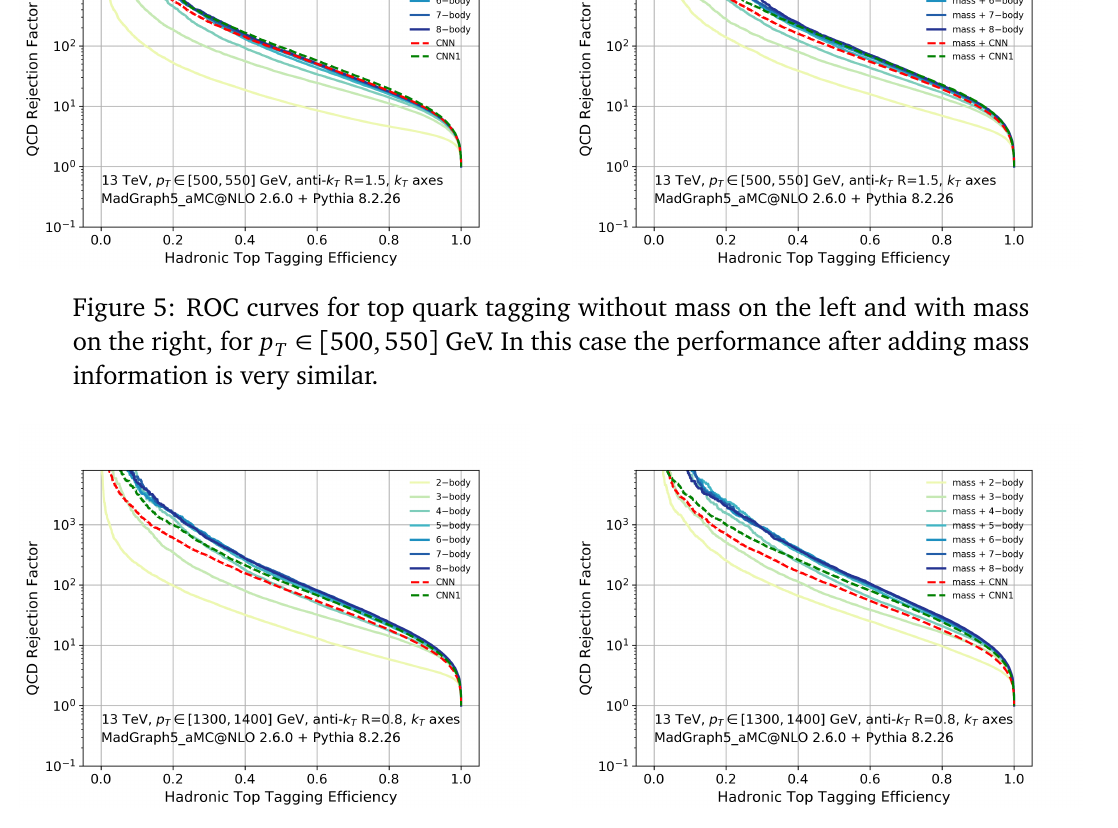
Figure 6: ROC curves for top quark tagging without mass on the left and with mass on ∈ [ 1300,1400 ] GeV. The image networks once again under-perform the right, for p T before adding mass information, but is slightly better at high signal efficiency after mass information is